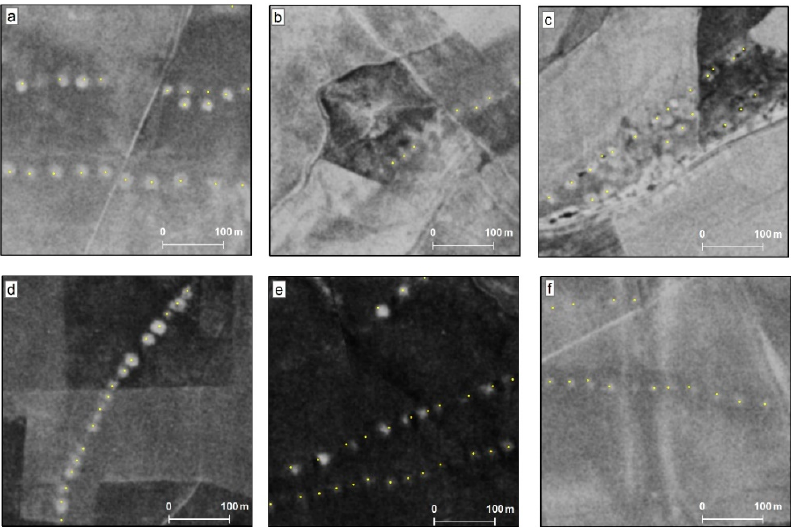
Figure 3. Qanat shafts, when well preserved ( a , d , e ) are relatively easy to identify and validate on the CORONA imagery based on the linear alignment of light dots on a darker background. The certainty of identification is lower when preservation is very poor ( f ) and when natural landscape has a similar signature of white patches on darker background ( b , c ). In this project, however, shafts with all levels of certainty are labeled and used in training. (Yellow dots are laid over qanat shafts to emphasize the locations of individual shafts.)